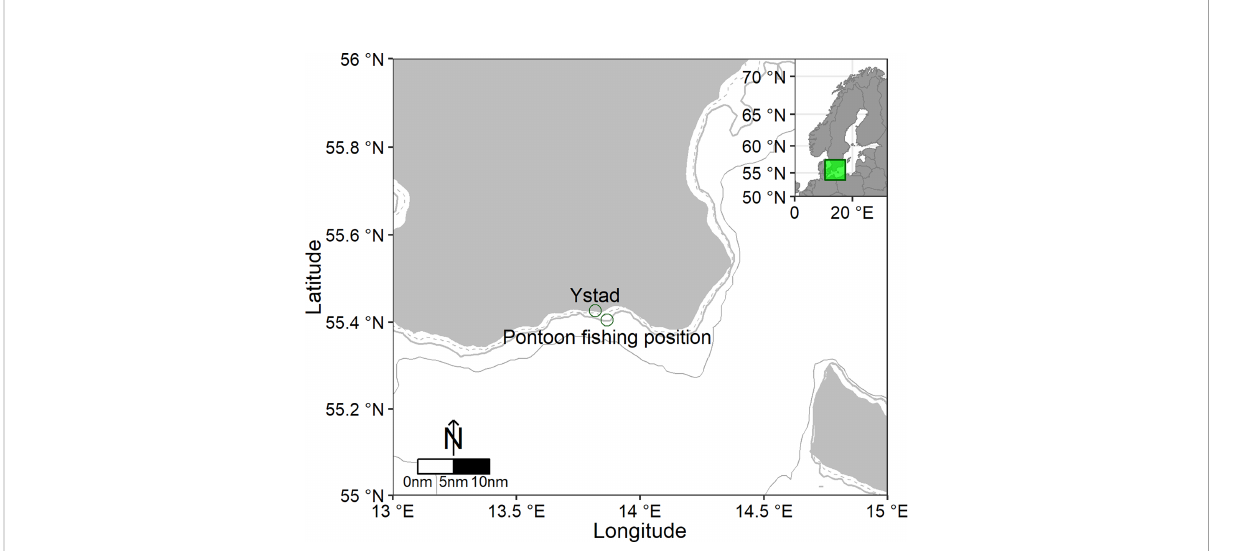
FIGURE 1 Map of the southern Baltic Sea and surrounding waters. Green circles indicate the port of Ystad and the position of the pontoon trap. Dashed line is the 5 m, thicker grey the 10 m and thinner grey the 20 m depth